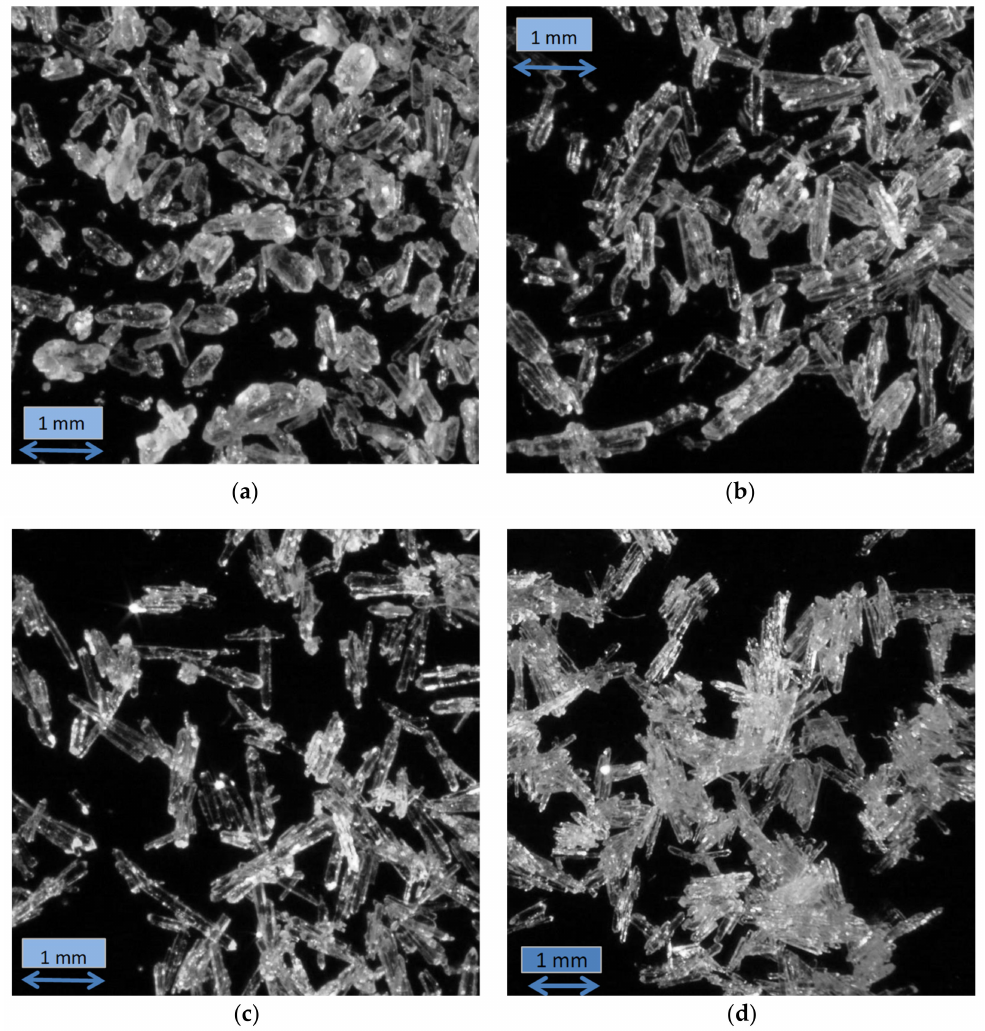
Figure 7. ( a ) Crystals after washing for a concentration factor of two. ( b ) Crystals after washing for a concentration factor of three. ( c ) Crystals after washing for a concentration factor of four. ( d ) Crystals after washing for a concentration factor of